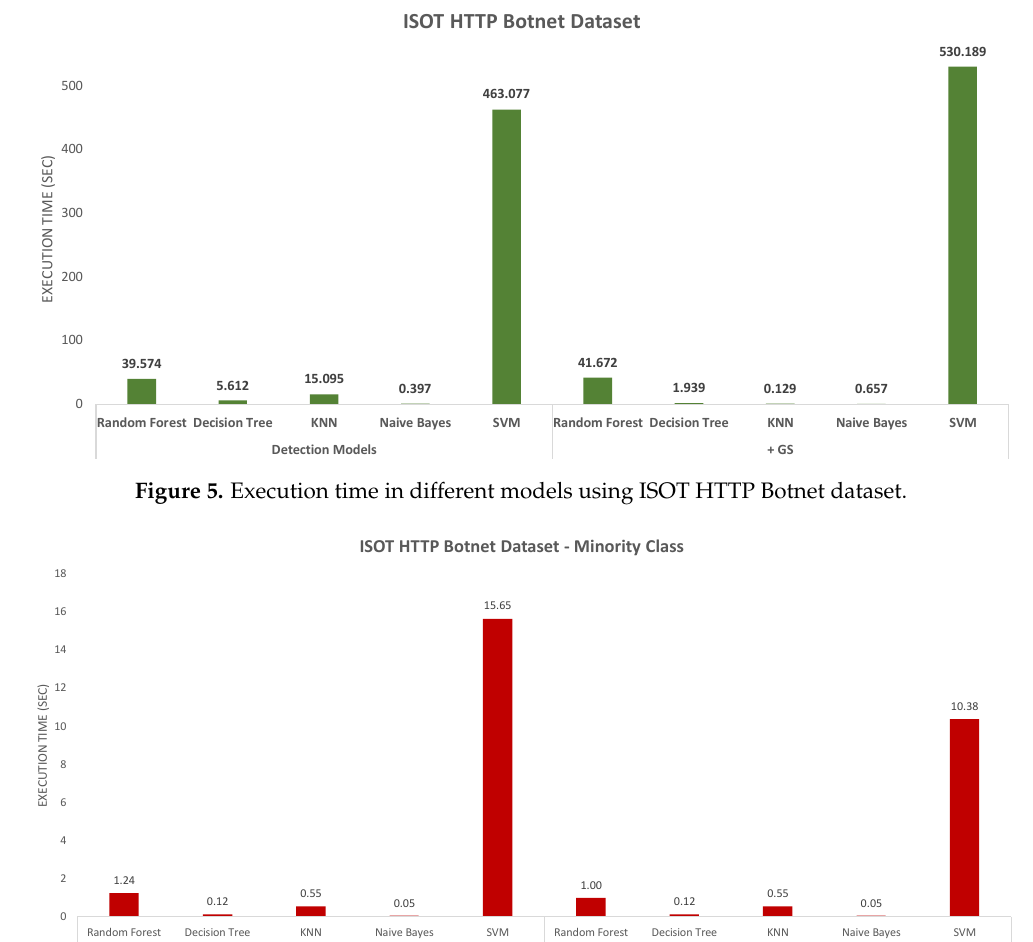
Figure 4. Execution time in different models using CIC-AWS-2018 dataset filtered by TCP.